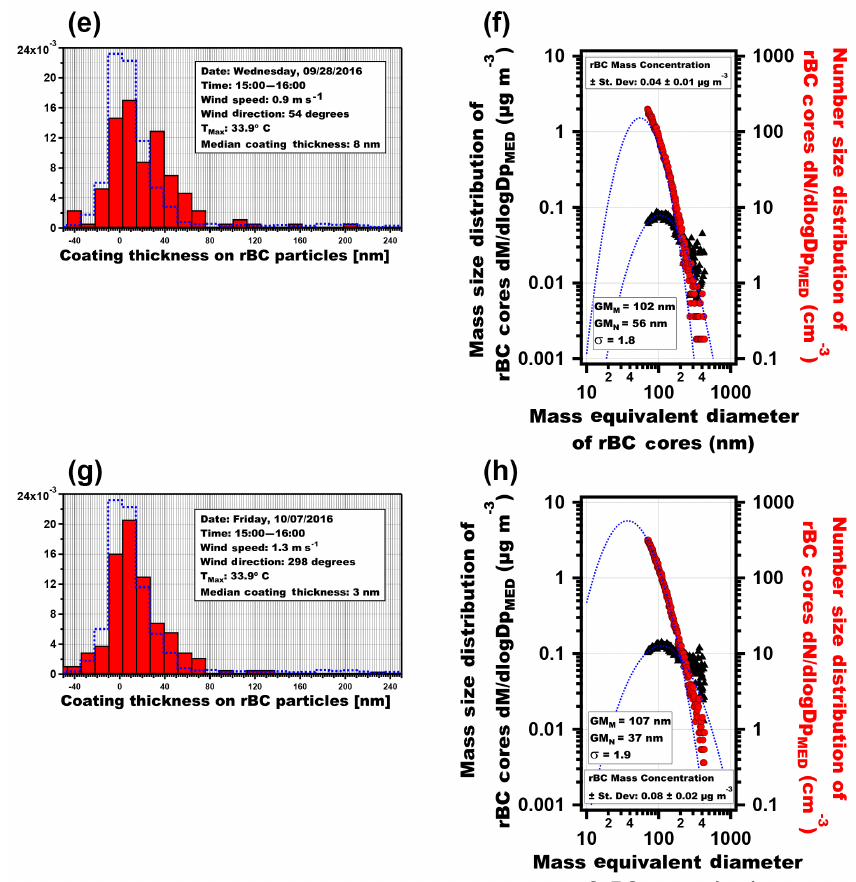
Figure 11. Coatings thickness histograms (a, c, e, g) and rBC number and mass size distributions (b, d, f, h) for 2 Sundays (a–d) and 2 weekdays (e–h) averaged for 15:00–16:00 in Redlands. Also shown in the insets are meteorological variables and median coating thick- nesses (a, c, e, g) and rBC mass concentrations (b, d, f, h) for each of the four afternoons. Note that corresponding back trajectories are shown in Fig. 10. Coating thickness histograms in red are for Redlands and the near-road histogram (equivalent to that shown in Fig. 4) is shown with blue dashed outlines. Lognormal fits and their corresponding geometric means (GM) and standard deviations ( σ ) are shown for each rBC size